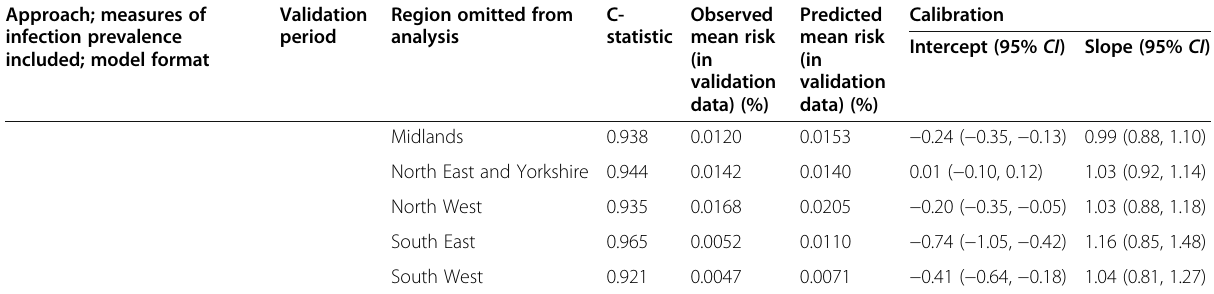
Table 4 Measures of model performance in predicting 28-day risk of COVID-19 mortality in the temporal and geographical internal validation, using the “ selected ” models (Continued) Approach; measures of infection